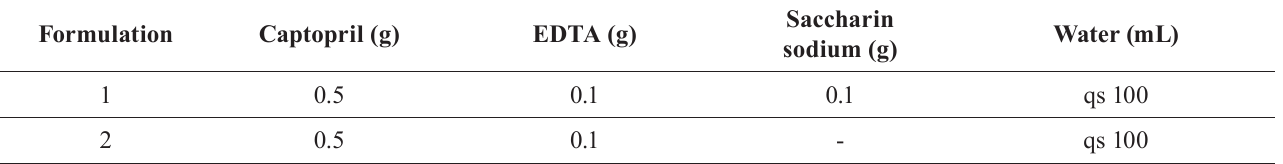
TABLE I - C omposition of the captopril